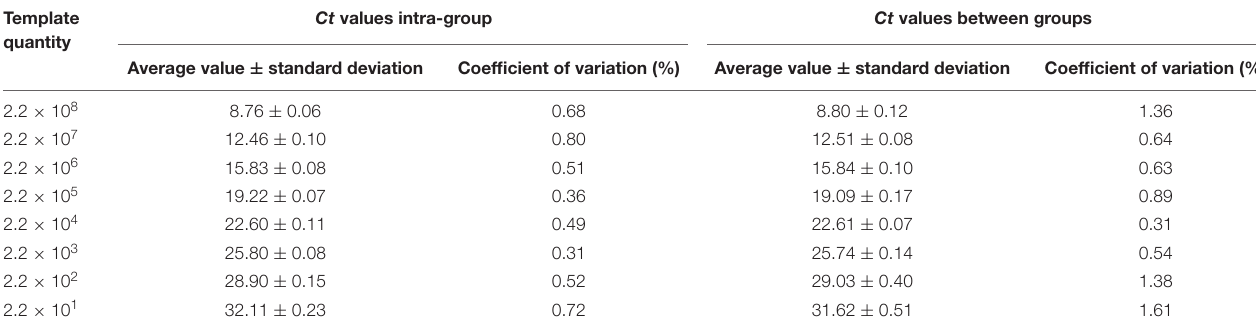
TABLE 2 | Repeatability of detection of EAM by RPS9-qPCR. Template Ct values intra-group Ct values between groups quantity Average value ± standard deviation Coefficient of variation